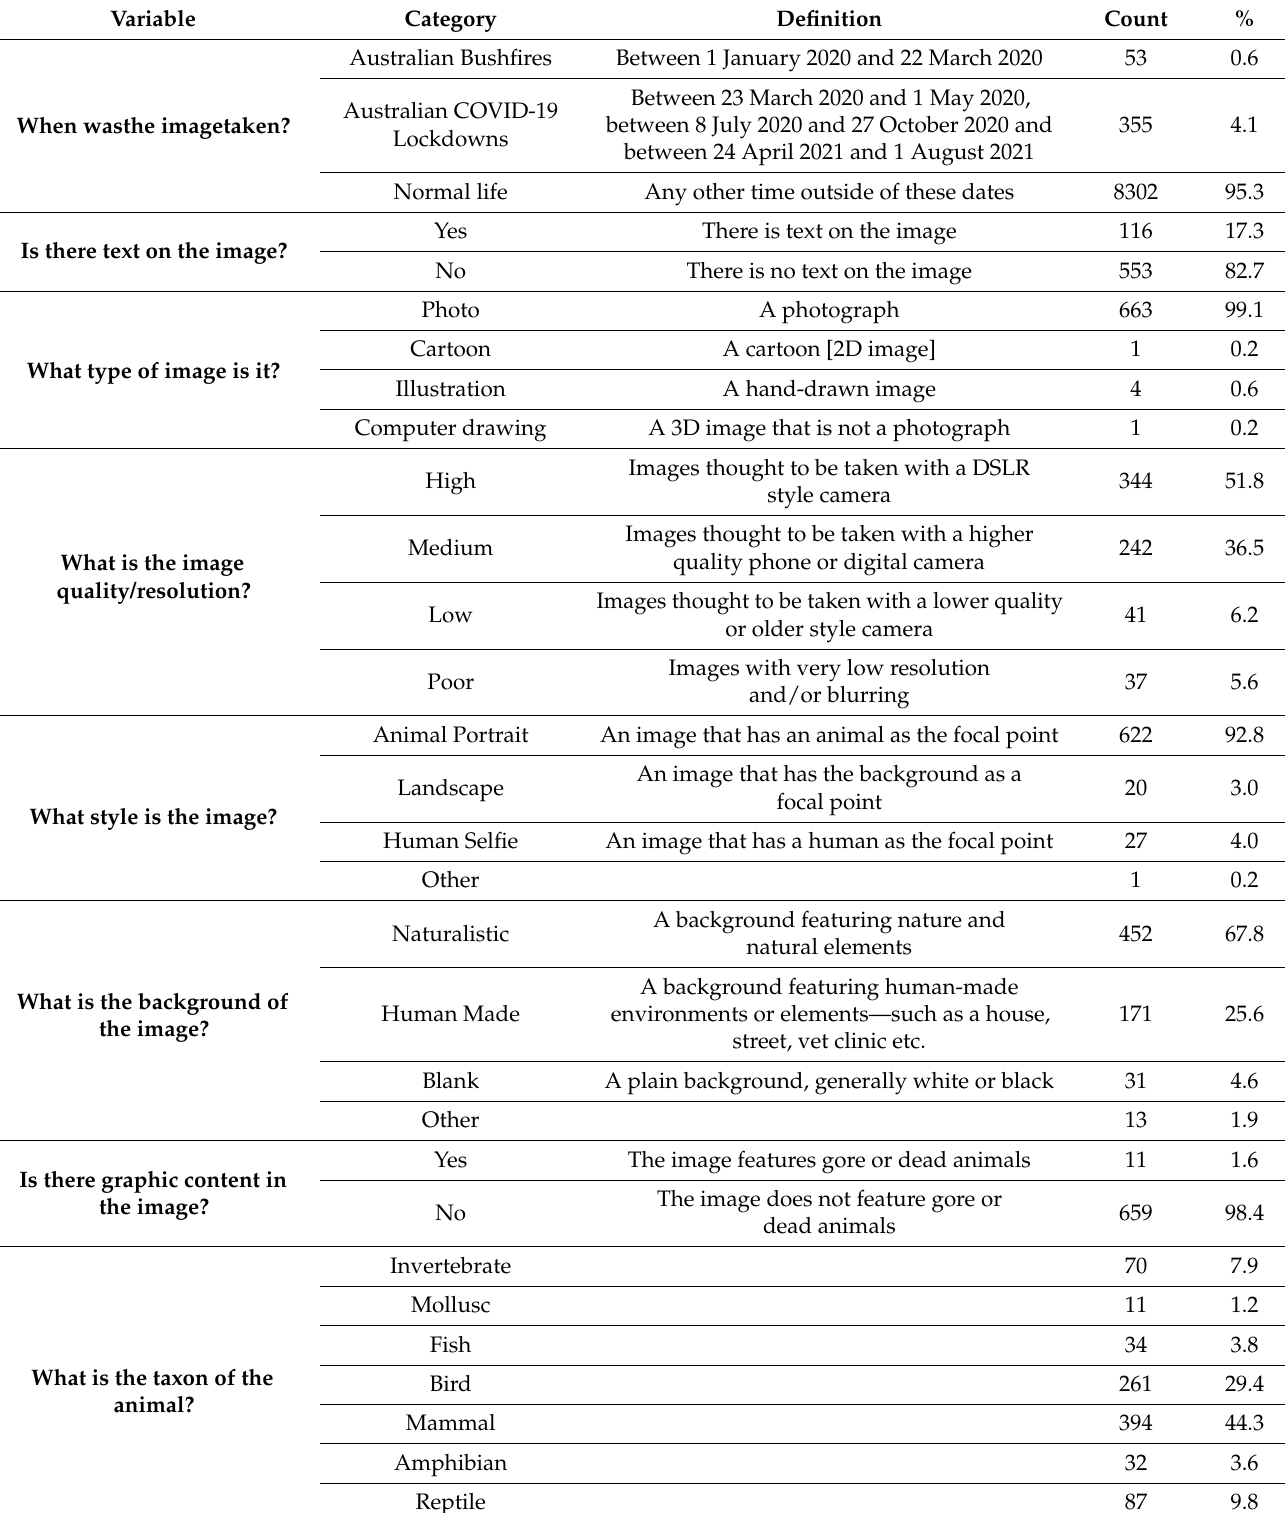
Table 1. The frequency of elements in a sample of 670 wildlife images posted on Instagram by Australian conservation